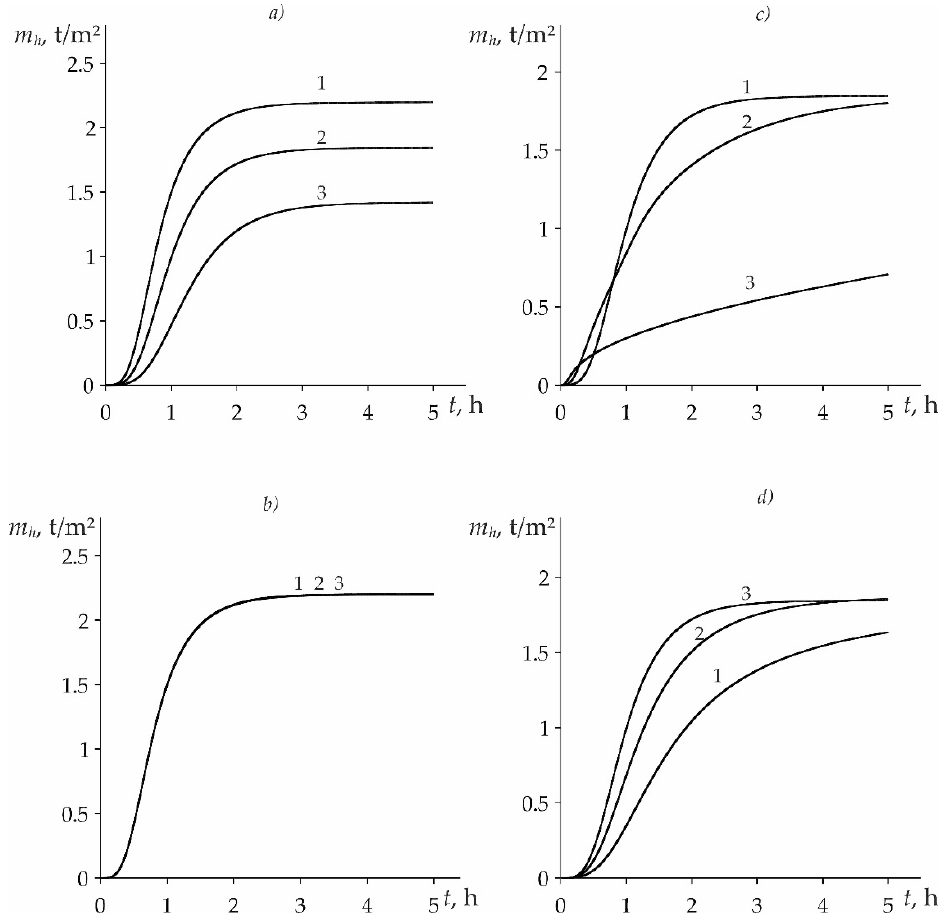
Figure 6. The change in time of the formed hydrate mass at various pressures ( a ) and temperatures ( b ) of injection, permeability ( c ) and porosity ( d ) of the reservoir.